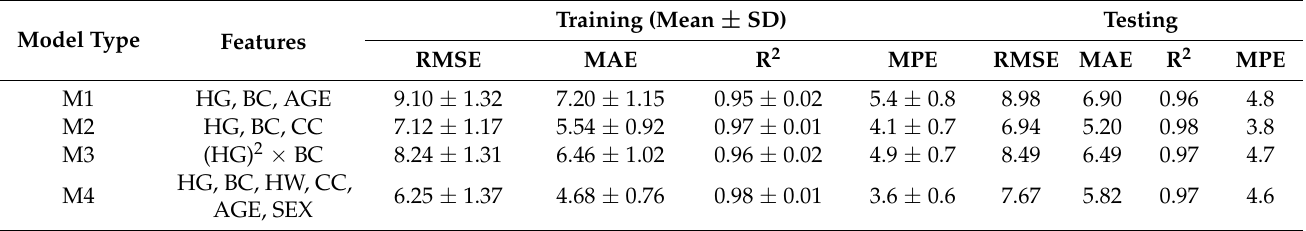
Table 3. Root-mean-square error (RMSE), mean absolute error (MAE), coefficient of determination (R 2 ) and mean percentage error (MPE) from the cross-validation using the training and testing datasets for four best performing models for predicting body weight of Icelandic foals: linear model featuring three traits (M1), quadratic polynomial (M2), linear model featuring a complex trait (M3) and a non-linear model based on the ExtraTreesRegressor algorithm (M4).